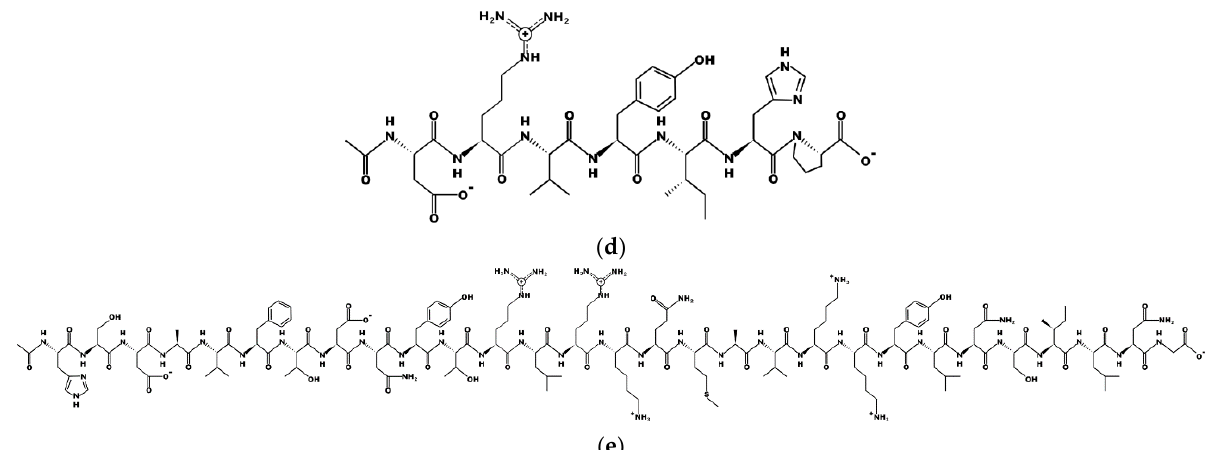
Figure 1. Schematic representation of selected peptides used in clinical trials. ( a ) Human ezrin peptide 324-337, HEP1; ( b ) thymosin-alpha ;1 ( c ) LSALT peptide; ( d ) angiotensin peptide (1-7); ( e ) vasoactive intestinal peptide (VIP) using the program PEPDRAW (http://pepdraw.com/) (accessed on 7 October 2021).